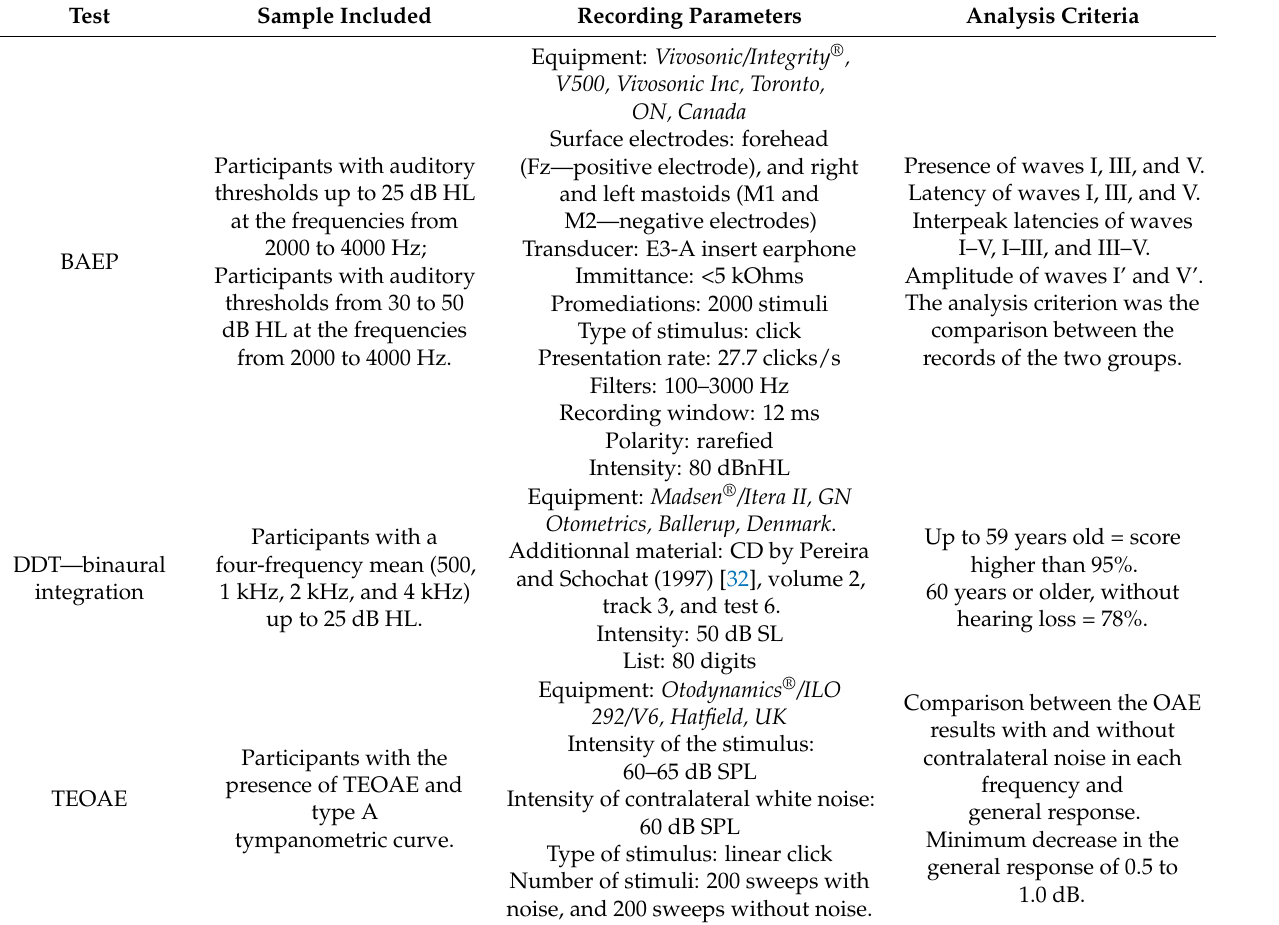
Table 1. Description, recording parameters, and analysis criteria of auditory tests performed in the exposed group and control